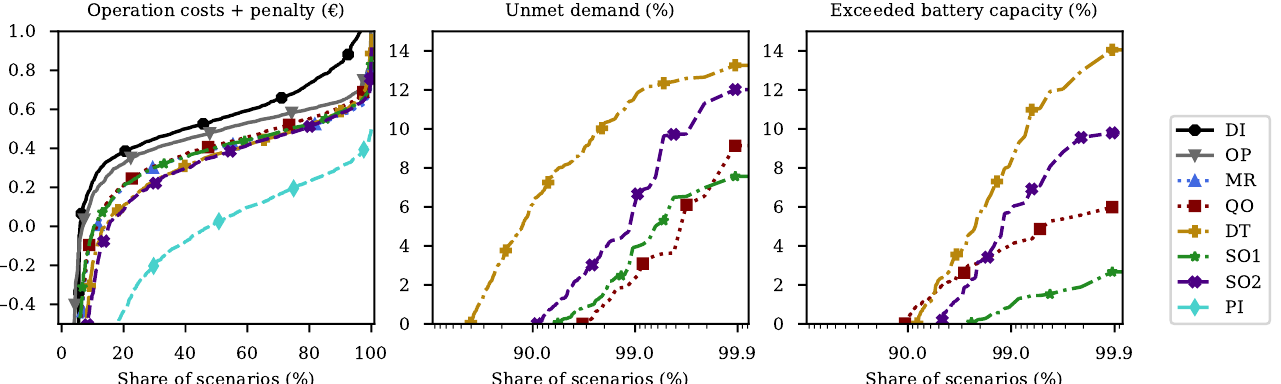
Figure 3. Results for the Dutch case study. The results show the performance for the x -th quantile in terms of operation costs plus penalty, unmet demand, and exceeded battery capacity. Note that the horizontal axes of the second and third plot are logarithmic